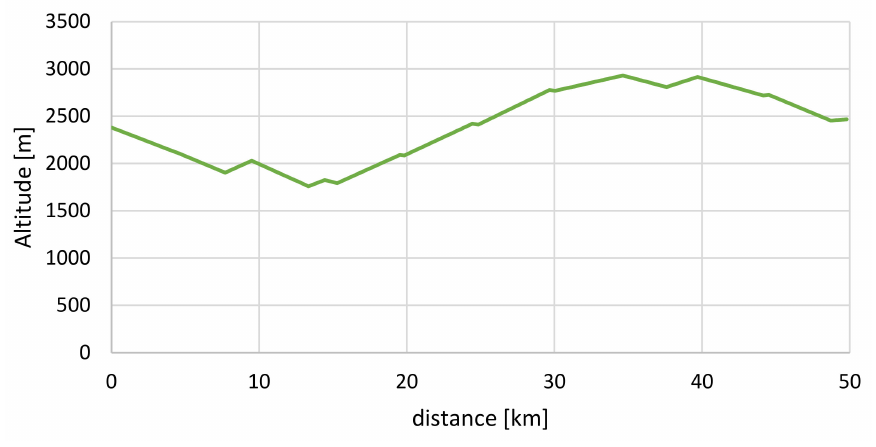
Figure 2. Elevation